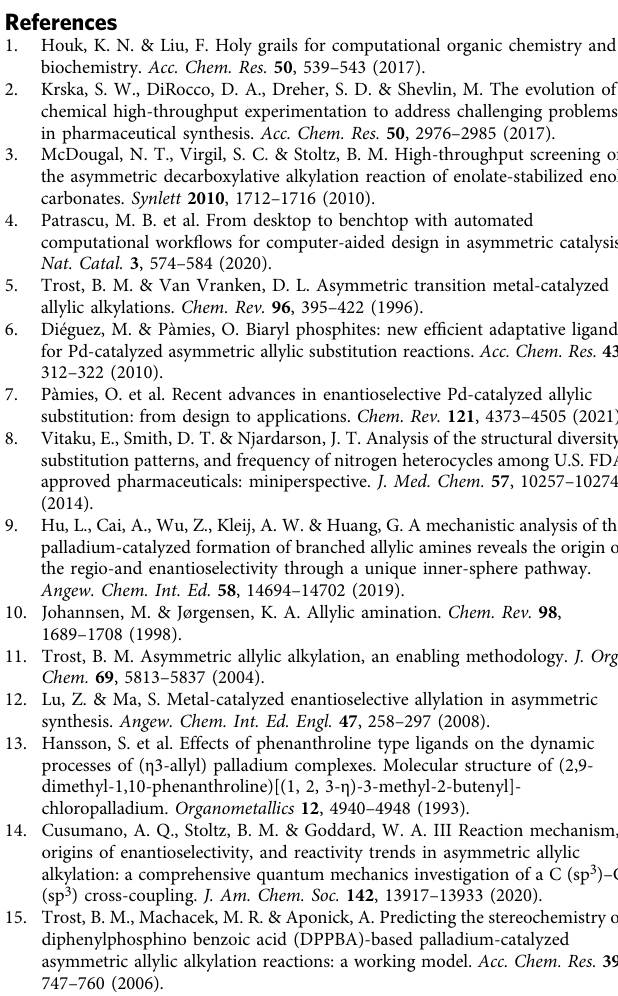
Fig. 4 Comparison of relative energies of the corrected experimental values to the calculated MM values. The absolute con fi gurations for the 11 data points in purple have been